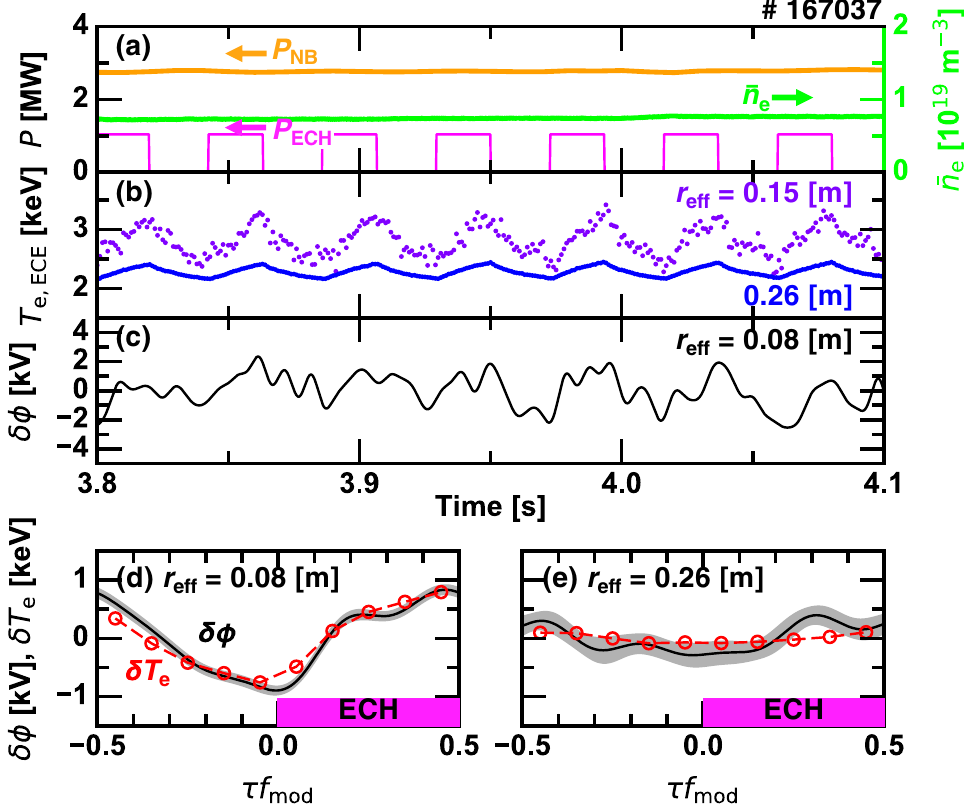
Figure 5. Time evolutions of ( a ) the heating powers and the line averaged electron density, ( b ) the electron temperature, and ( c ) the core electrostatic potential with a 100 Hz low-pass filter; and conditionally averaged electrostatic potential and electron temperature ( d ) inside and ( e ) outside the